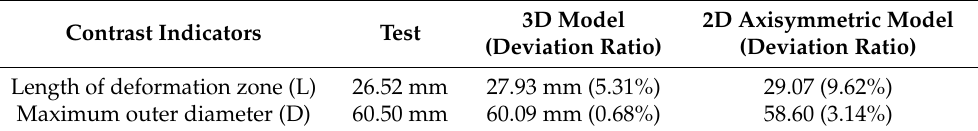
Figure 5. Comparison between experimental and numerical simulation results. ( a ) Test results; ( b ) 3D model simulation results; ( c ) 2D axisymmetric model simulation results. Table 3. Element mesh setting in finite element model. Table 3. Comparison of deformation results between test and simulation